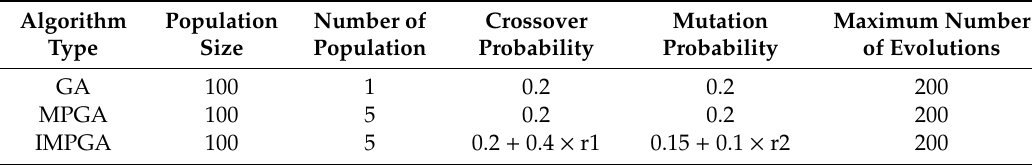
Table 2. Parameter settings of each